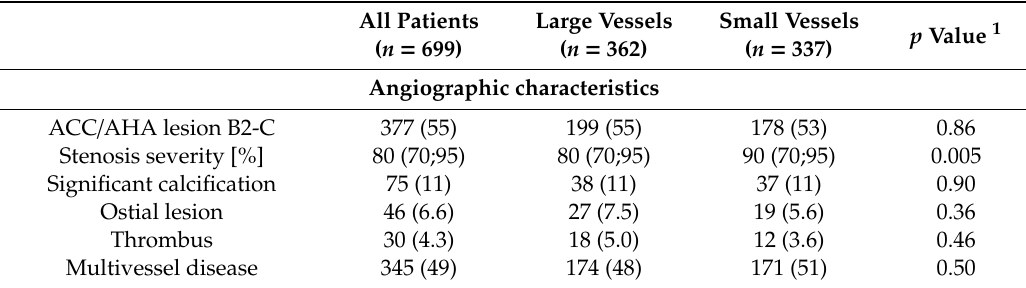
Table 2. Angiographic and procedural